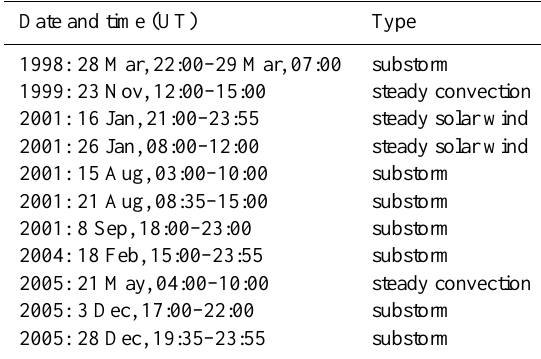
Table 1. Events for the energy transfer spatial dependence